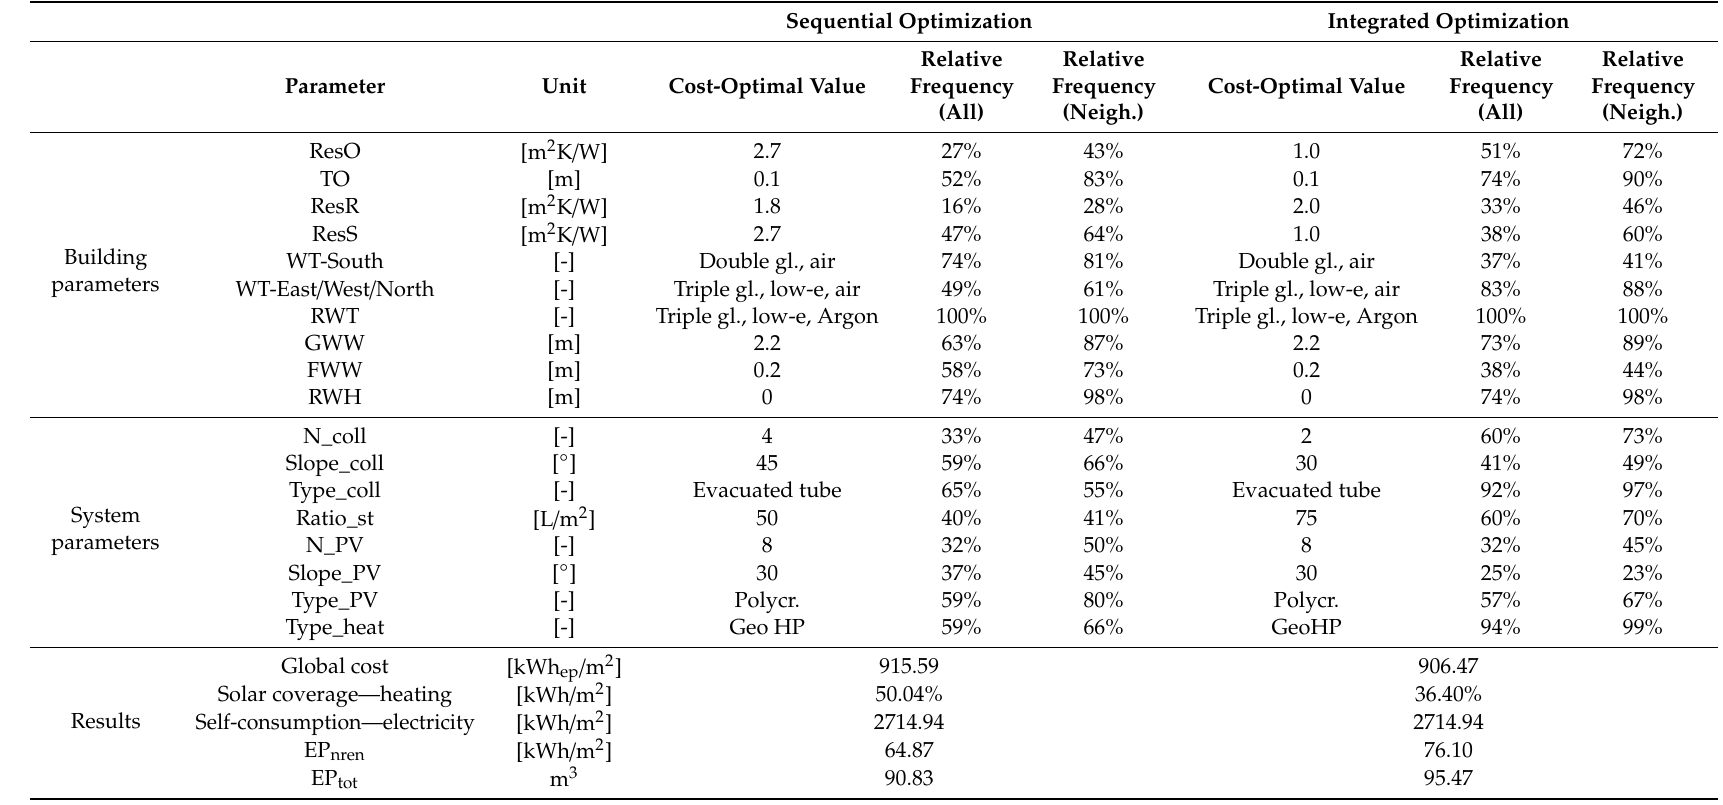
Table 6. Results of sequential and integrated optimizations with financial